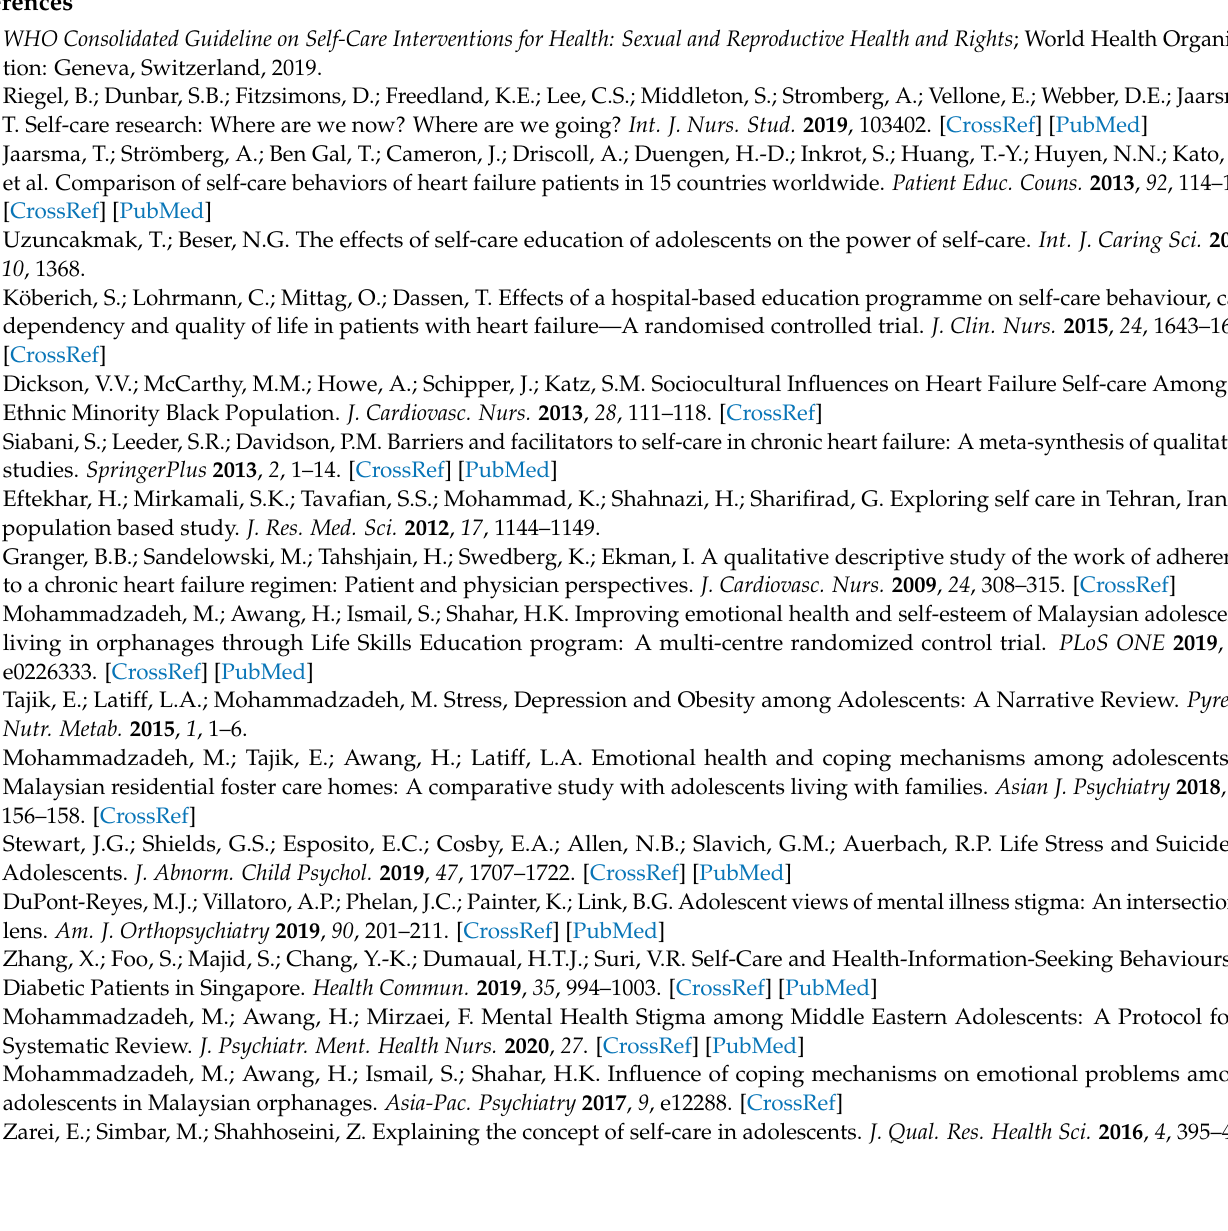
Figure A2. Suitable safe-care activities for female adolescents from their viewpoint.